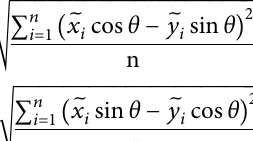
Figure 5. Community distribution and